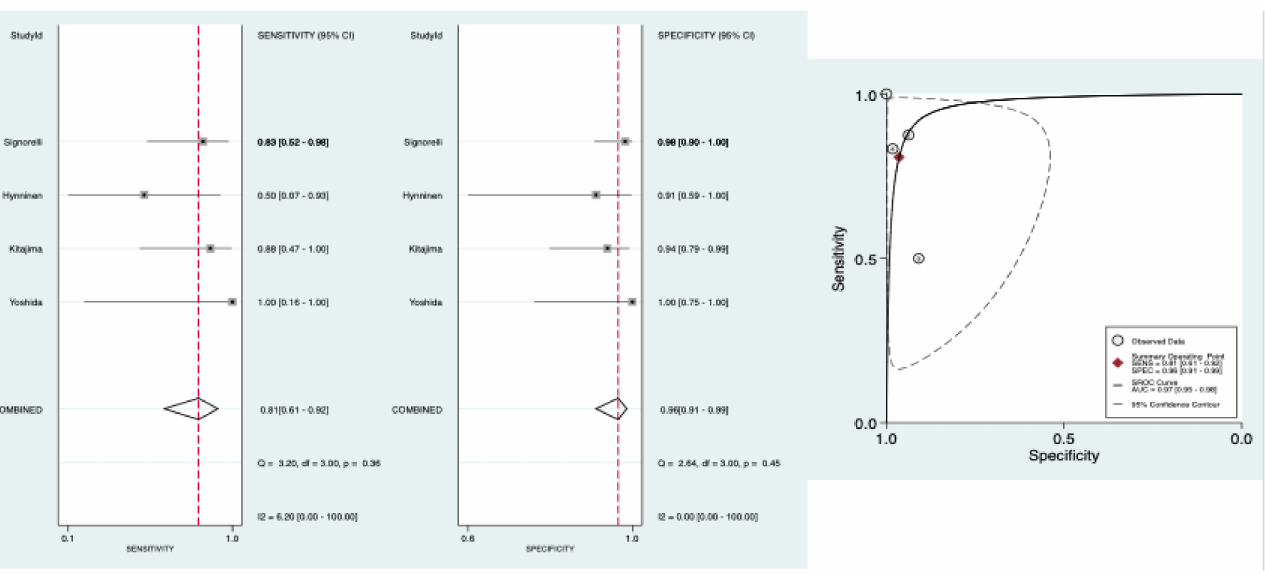
Figure 3. Forest plots of pooled sensitivity and specificity and HSROC of preoperative CT to detect pelvic and para- aortic LNM.